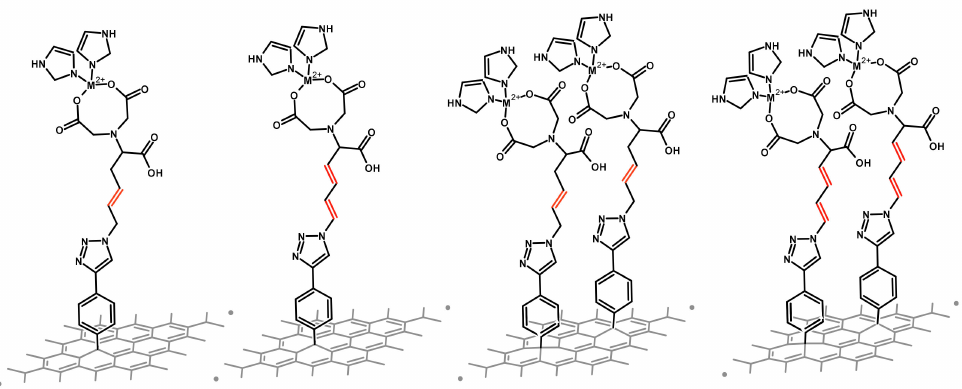
Figure 1. Schematic representation of the interfaces with two types of backbones studied in this work. Discussed double bonds are marked in red. The first two pictures are interfaces with 50% of coverage, the next two depict fully covered interfaces (100%